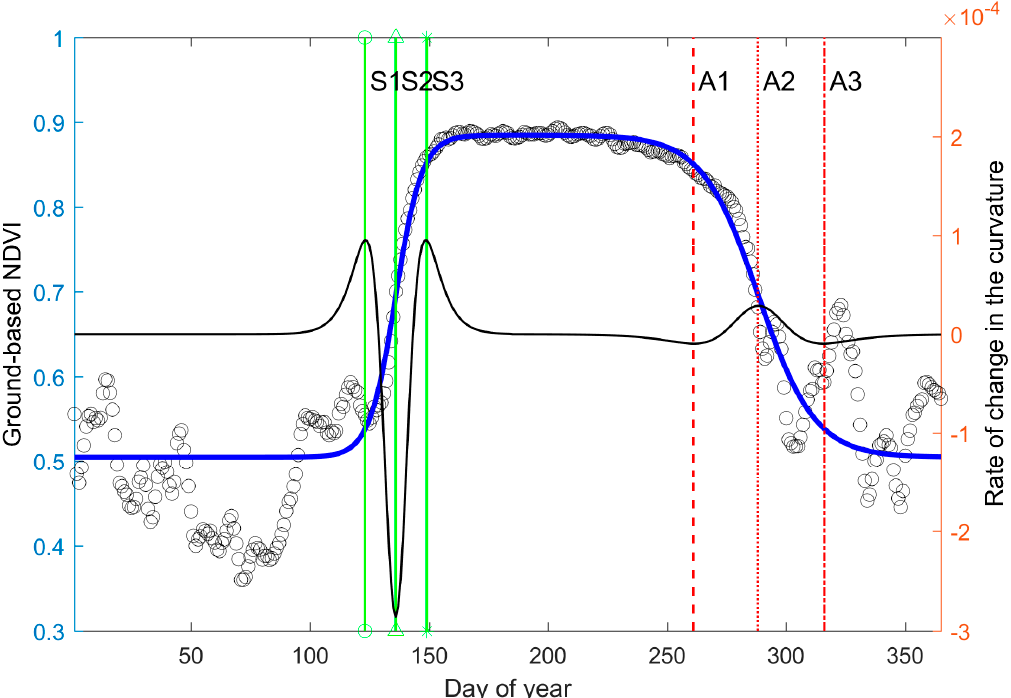
Figure 1. Illustration of estimating the six phenological markers from the fitted time series. We used the daily ground-based NDVI as an example. The ground-based and fitted NDVI time series at Harvard Forest in 2014 are plotted by the circles and blue line, respectively. The rate of change in the curvature is given by the first derivative of the fitted NDVI time series (black curve—right axis). The vertical lines show the four phenological markers derived from the fitted ground-based NDVI time series including S1, S3, A1 and A3 which represent the dates of the start of spring, the end of spring, the start of autumn and the end of autumn, respectively. In this study, the middle of spring (S2) and the middle of autumn (A2) are defined as the date at the fitted function reaches its half-maximum value in the ascendant/ descendent part of the fitted curve, respectively.